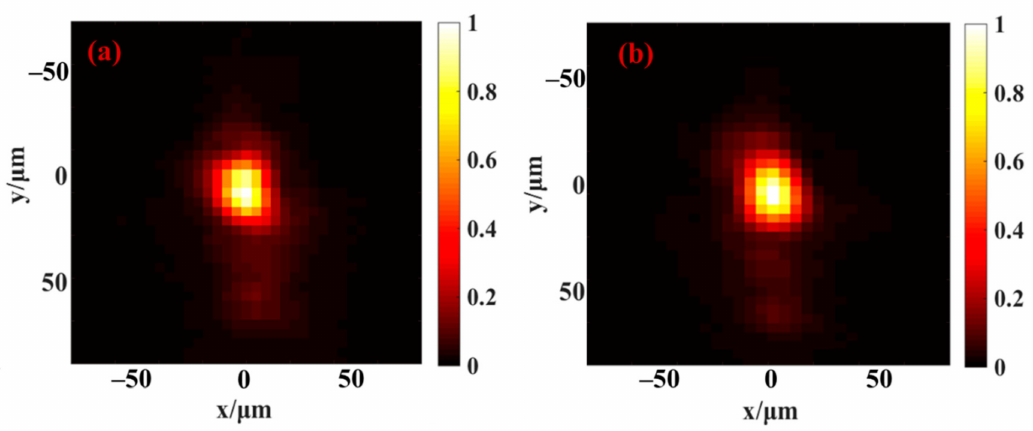
Figure 4. Far-field pattern results of output igniting laser: ( a ) Without SOCP. ( b ) With